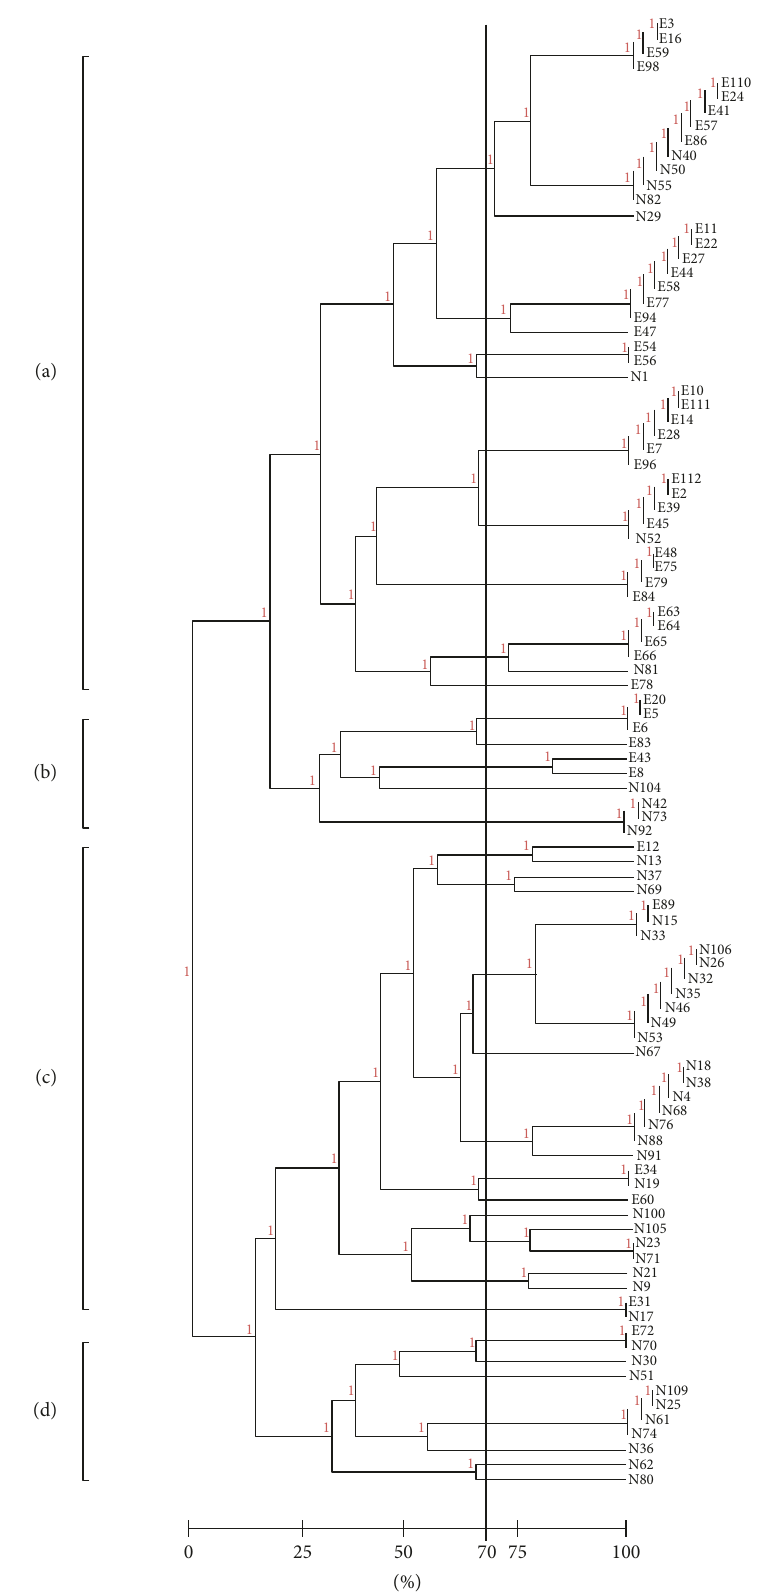
Figure 2: Dendrogram of RAPD-operon 18 profile of the 100 ESBLs and non-ESBLs producing K. pneumoniae . ( a) Cluster a, (b) cluster b, ( c) cluster c, and (d) cluster